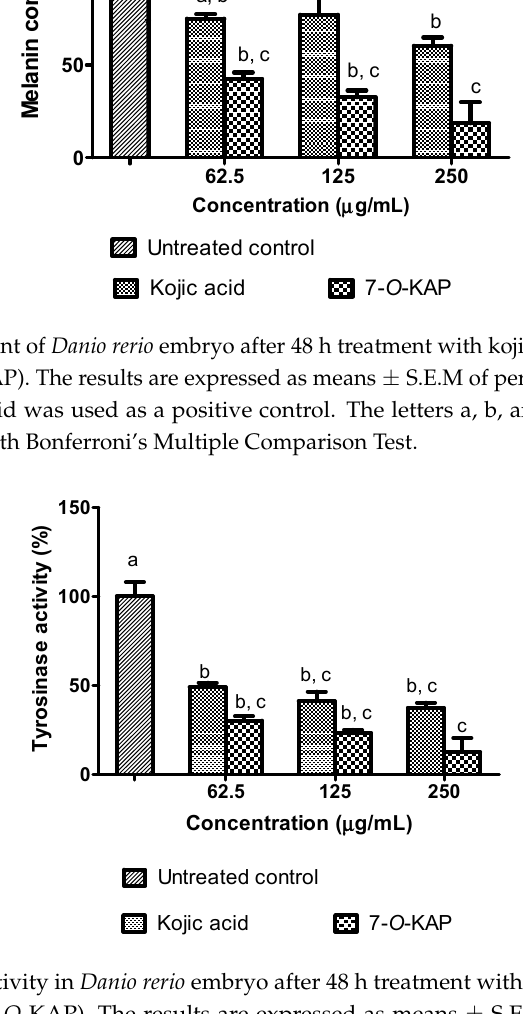
Figure 9. Tyrosinase activity in Danio rerio embryo after 48 h treatment with kojic acid and 7- O -kojic acid monopalmitate (7- O -KAP). The results are expressed as means ± S.E.M of percentage (%) to untreated control, n = 3. Kojic acid was used as a positive control. The letters a, b, and c indicate significant difference at p < 0.05 with Bonferroni’s Multiple Comparison Test.